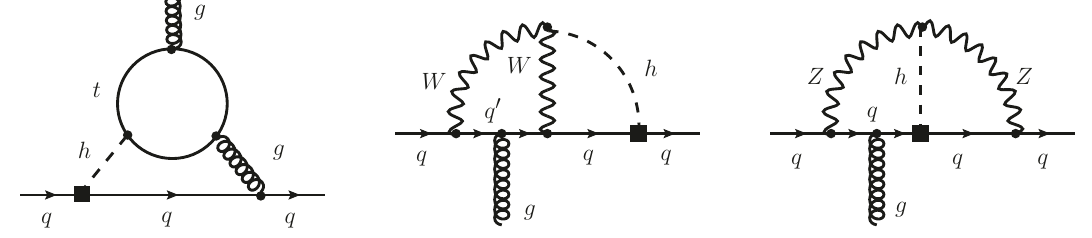
Figure 2 . Sample two-loop Feynman diagrams inducing an chromoelectric dipole moment for the light quark q = u; d; s through a CP-violating Higgs coupling. The label q 0 denotes a quark with opposite weak isospin with respect to q